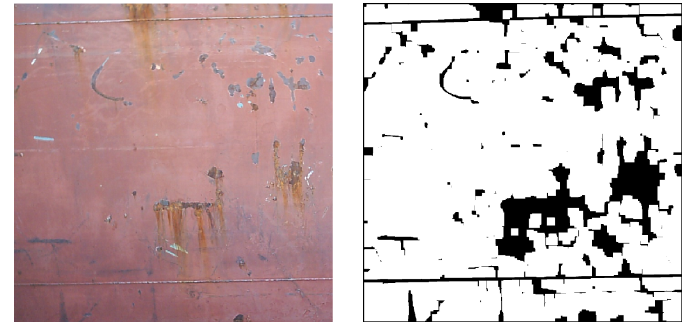
Figure 13. The result of UBE method after to process on a slice of 2 × 2 m of ship’s